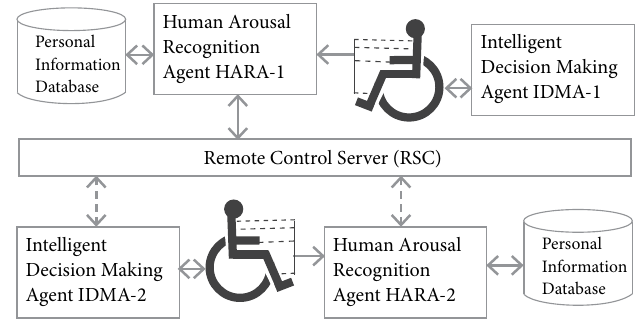
Fig. 1. The reinforcement framework of an intelligent remote bio-robots interaction based on distributed information